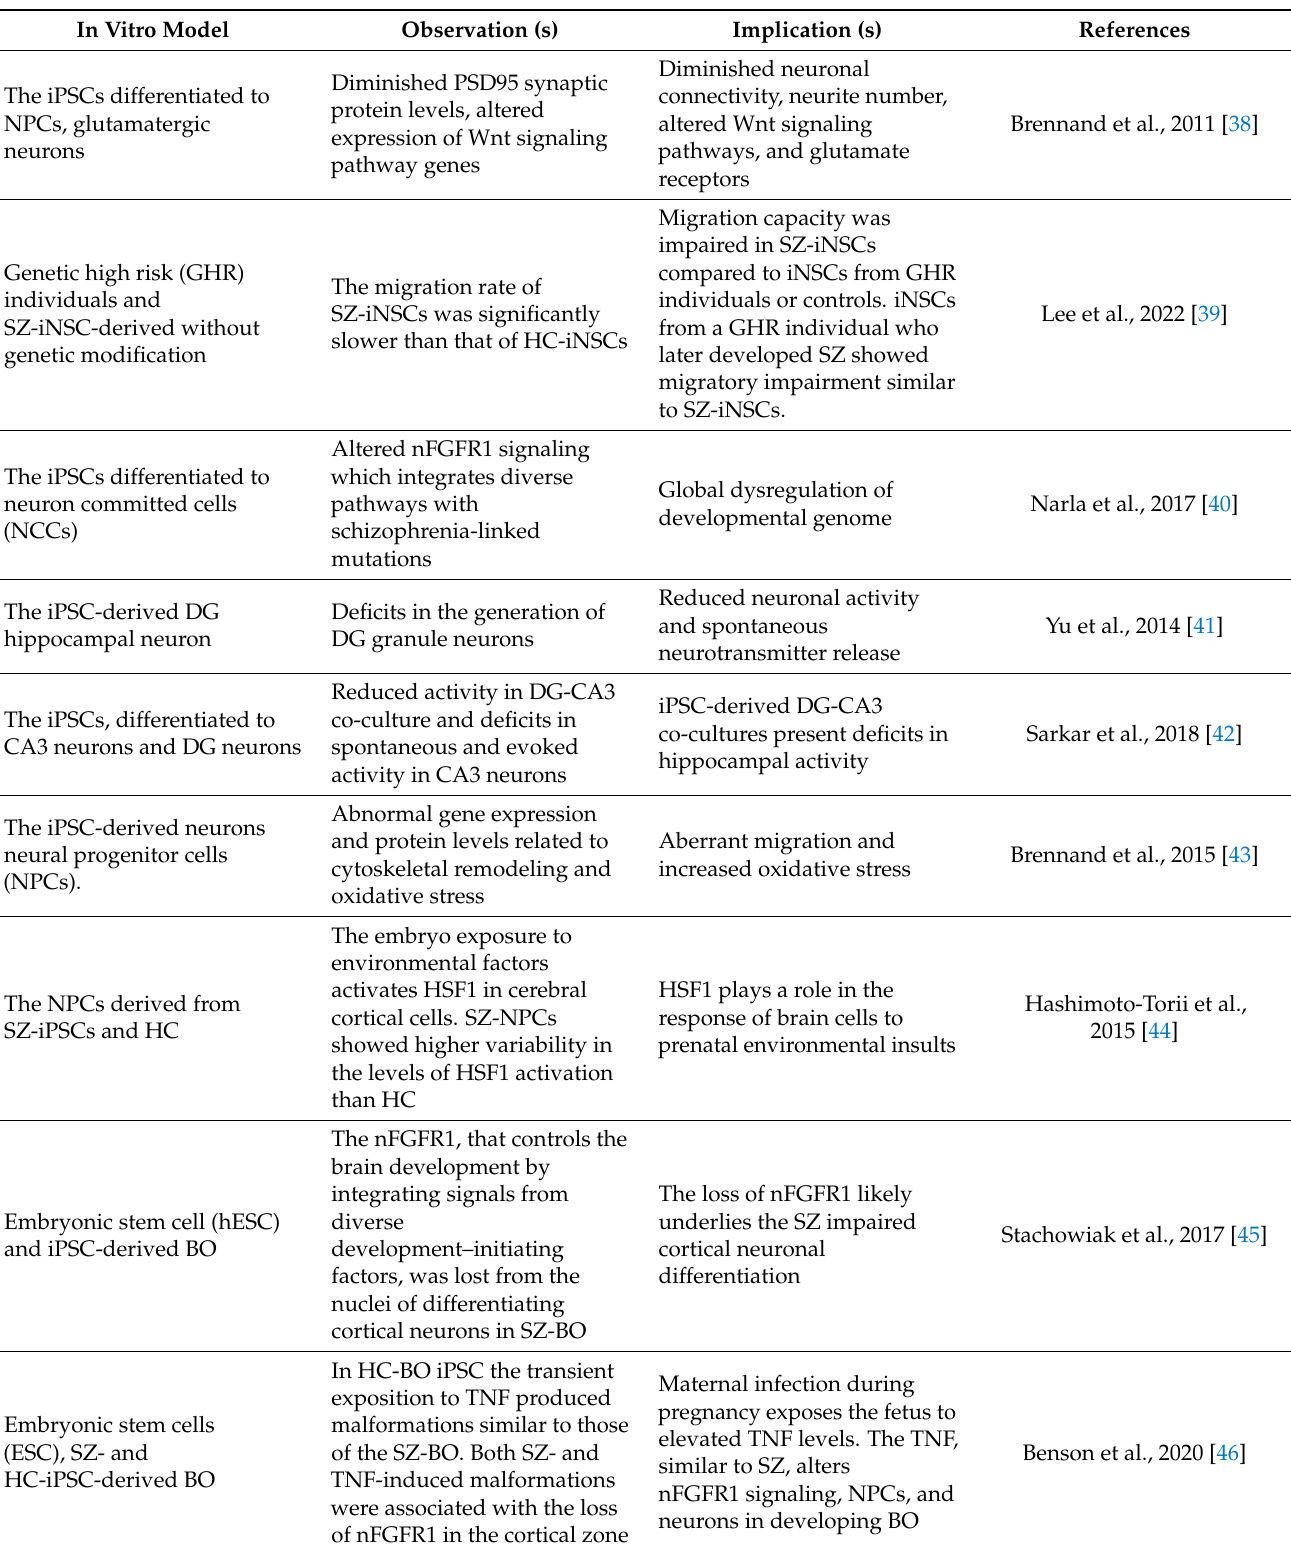
Table 1. Selected studies investigating schizophrenia using iPSCs from